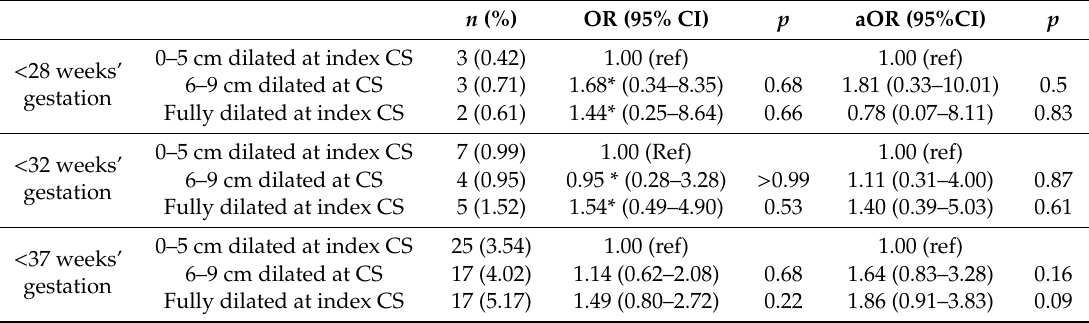
Table 3. Risk of spontaneous preterm birth in a subsequent pregnancy at < 28, < 32 and < 37 weeks’ gestation following an emergency caesarean section at 0–5, 6–9 of full cervical